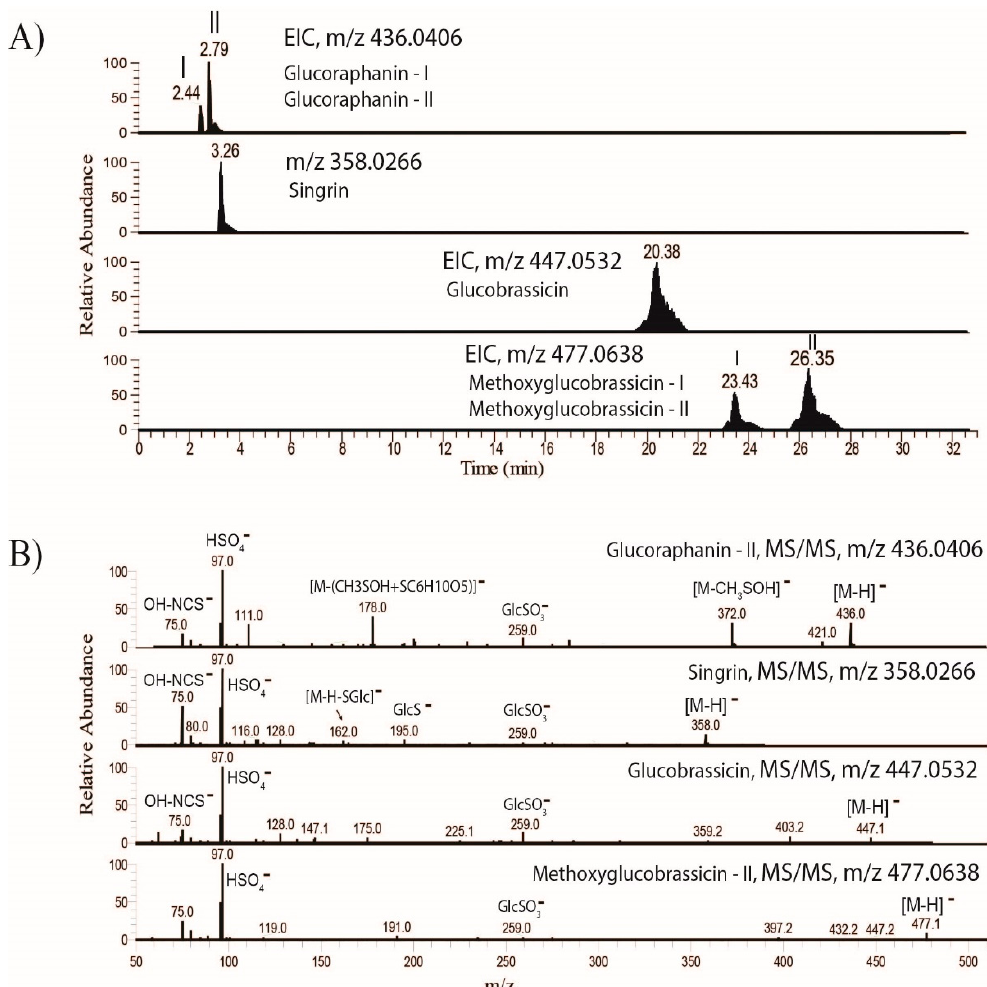
Figure 2. Representative LC-MS/MS profiles of kale glucosinolates. ( A ) Extracted ion chromatograms (EIC) and ( B ) the corresponding fragmentation spectra of glucoraphanin sinigrin, glucobrassicin, and methoxyglucobrassicin.